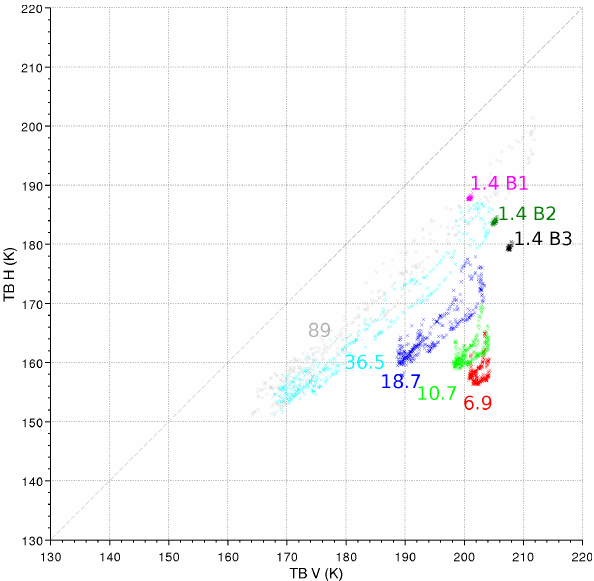
Fig. 8. TB H as a function of TB V at Dome C, Antarctica, using one year of data; 2013 Aquarius TBs and 2012–2013 AMSR2 TBs were used providing 1.413GHz data at three different incidence angles, and 6.9, 10.7, 18.7, 36.5, and 89GHz